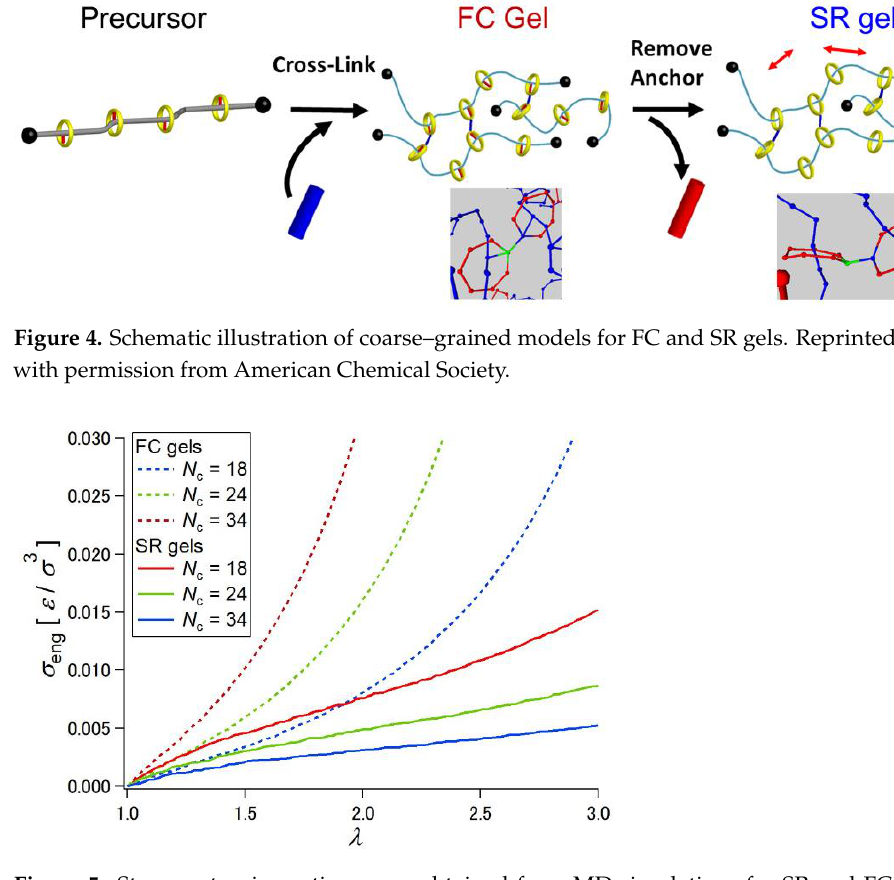
Figure 5. Stress–extension ratio curves obtained from MD simulations for SR and FC gels with different cross-linking densities. Reprinted from [27] with permission from American Chemical Soci- ety.